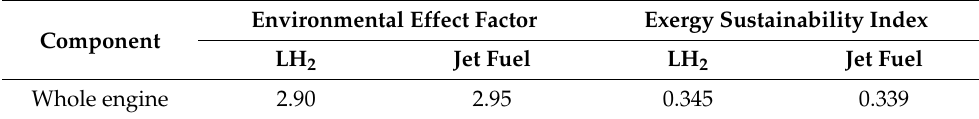
Table 7. Environmental effect factor and sustainability